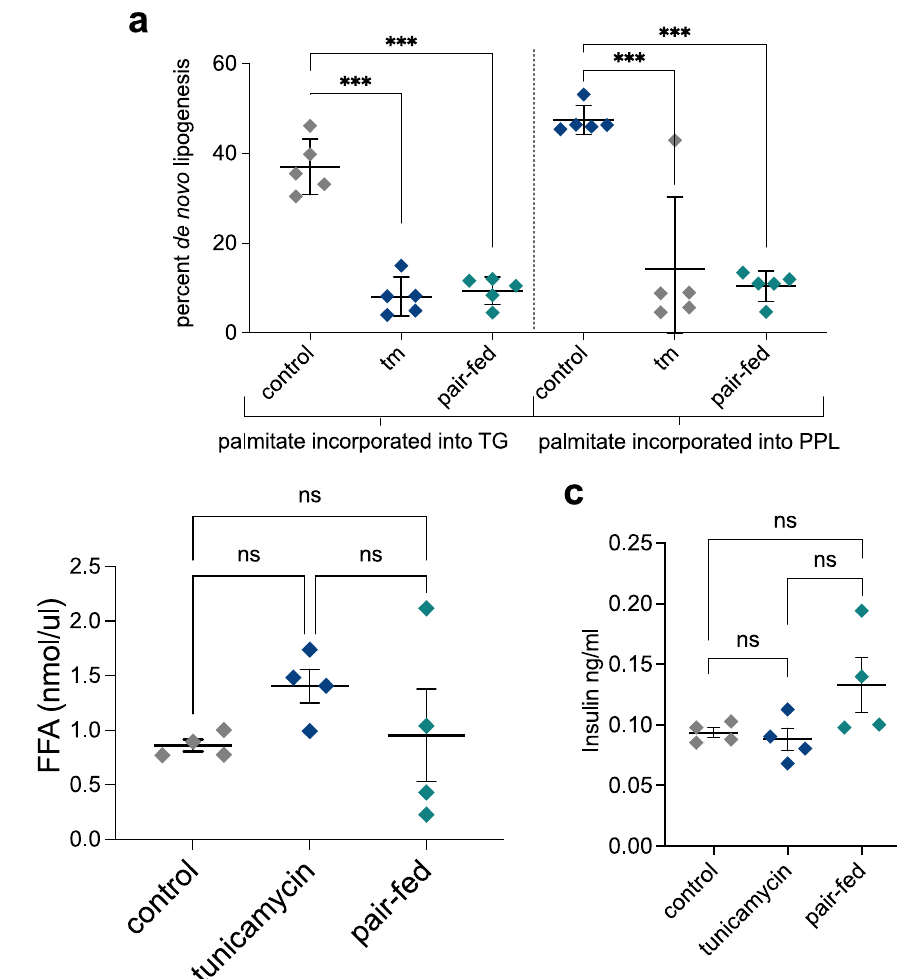
Figure 6. Hepatic de novo lipogenesis, free ‐ fatty acid (FFA), and insulin at 72 h post treatment. ( a ) Hepatic de novo lipogenesis in pair ‐ fed mice matched to tunicamycin treated mice. ( b ) Serum FFA at 72 ‐ h post treatment in control, tunicamycin, and pair ‐ fed mice. ( c ) Serum insulin at 72 h post treatment in control, tunicamycin, and pair ‐ fed mice. N = 5 mice per group. ns = no significance, *** = <0.001.